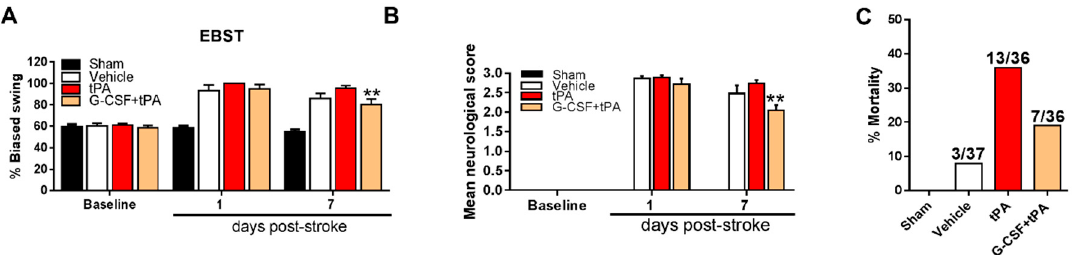
Figure 2. Effects of G-CSF on delayed tPA-induced motor and neurological deficits and mortality. ( A ) G-CSF treatment reduced delayed tPA-induced motor deficits by 15% as measured by the elevated body swing test (EBST); ( B ) G-CSF also reduced stroke and/or delayed tPA-induced neurological impairment by 25% when administered 7 days after stroke; ( C ) G-CSF decreased the incidence of mortality by 46% in stroke rats given tPA 6 h after stroke; ** p < 0.01 tPA vs. G-CSF + tPA, n = 10 rats per group. The data are expressed as mean ± S.E.M.